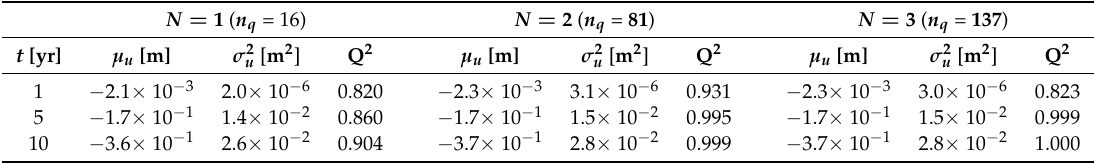
Table 1. Mean µ u , variance σ 2 u and coefficient Q 2 with the generalized Polynomial Chaos Expansion (gPCE) approximation up to degree N = 1, N = 2 and N = 3 (sparse grid). N = 1 ( n q = 16) N = 2 ( n q = 81 ) N = 3 ( n q = 137